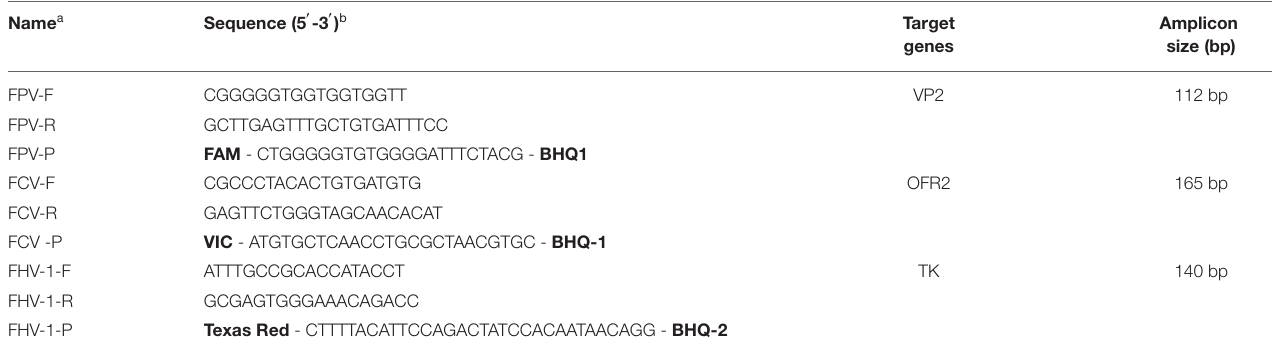
TABLE 1 | Primers and